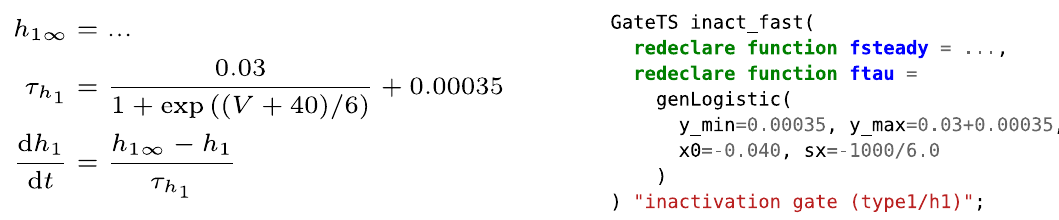
Fig 5. Equations for the fast inactivation gate of I Na in the original article (left) and in InaMo (right). The equations on the left- hand side constitute a typical description of an HH-type ion channel using a steady state h 1 1 and a time constant t to define the h 1 time course of the gating variable h 1 via a differential equation. The equation for t was found by fitting a generalized logistic h 1 function to experimental data. It has a declining sigmoid shape with an inflection point at 40 mV, a minimum of 0.35 ms, and a maximum of 30.35 ms. This may be apparent for an expert modeler, who is familiar with similar models, but not to novices or biologists without a deep mathematical background. The InaMo code on the right-hand side therefore aims to make this expert view of the equations available to non-experts by capturing common equation structures in named and documented components. GateTS defines a HH-type gating variable based on the two replaceable functions fsteady for the steady state and ftau for the time constant. genLogistic is a fitting function, whose parameters are explained in its documentation: y_min is the minimum, y_max is the maximum, x0 is the inflection point, and sx determines the steepness and direction ( sx < 0 yields a declining sigmoid